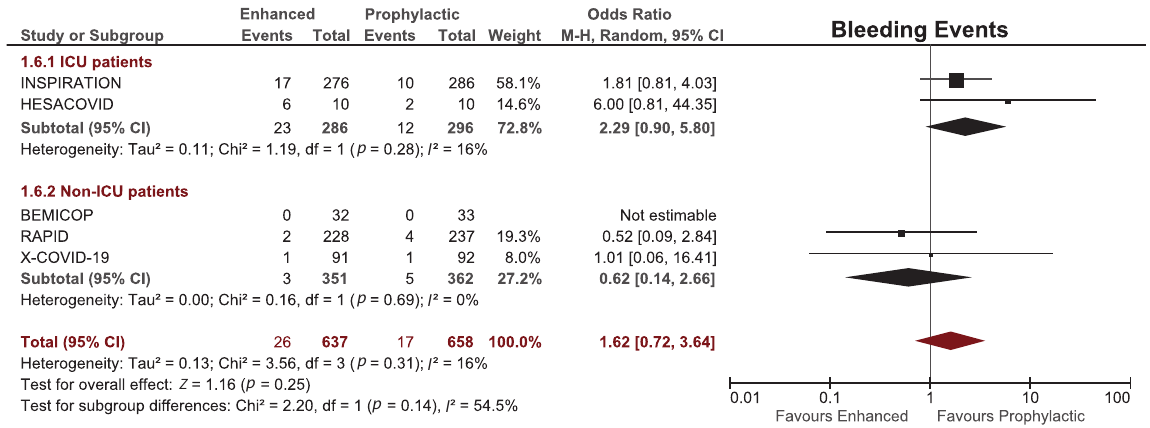
Fig.7 Subgroup analysis of bleeding events in ICU and non-ICU patients who received enhanced (therapeutic/intermediate) versusprophylactic anticoagulation. CI, con fi dence interval; ICU, intensive care